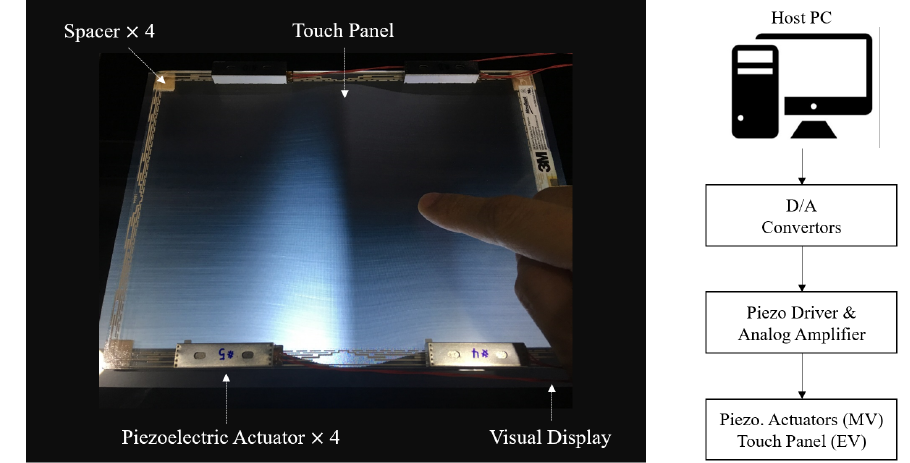
Figure 1. Custom-built hardware set-up for the experiments.